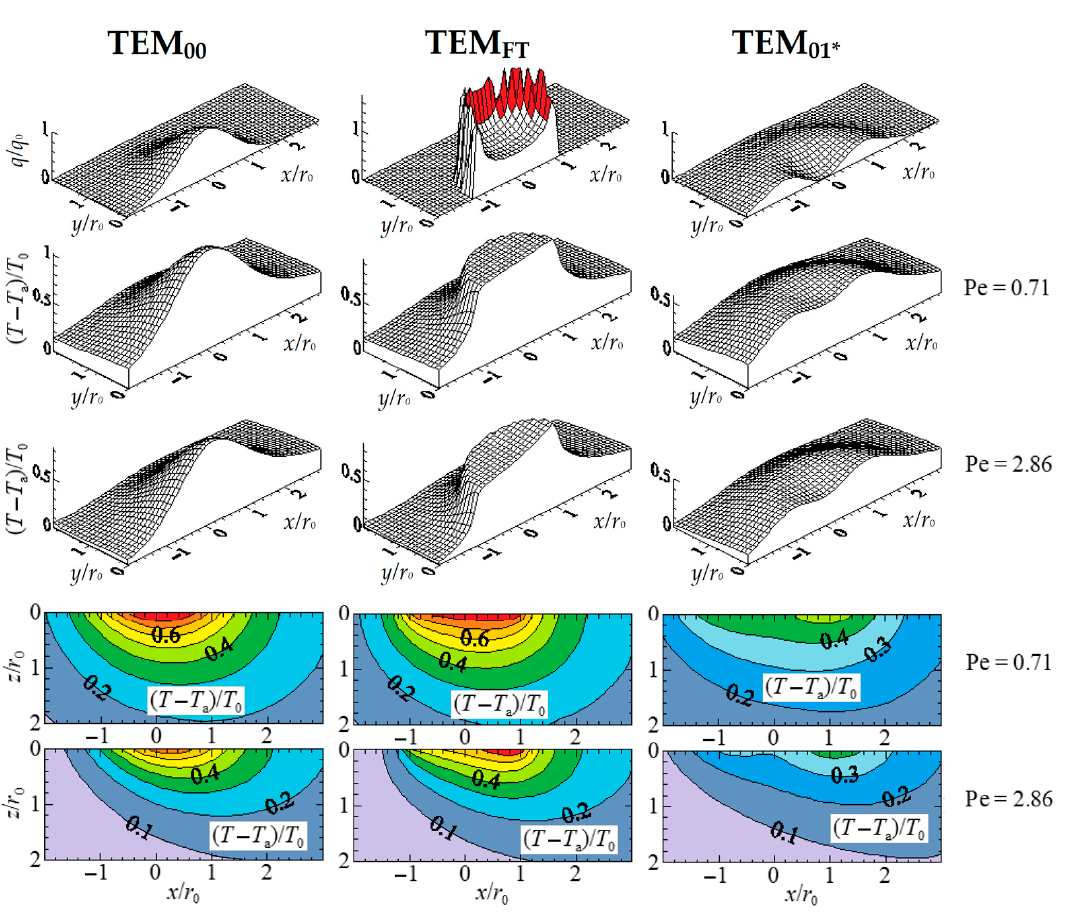
Figure 2. Normalized distributions: flux density of the absorbed laser energy q over the target surface z = 0 (top row); temperature T over the target surface (second and third rows); temperature T over the vertical plane of mirror symmetry y = 0 formed by the beam axis and the scanning line (two rows on the bottom). Red in the q / q 0 graph indicates the approach to the area of the discontinuity at the beam boundary where r = r 0 .